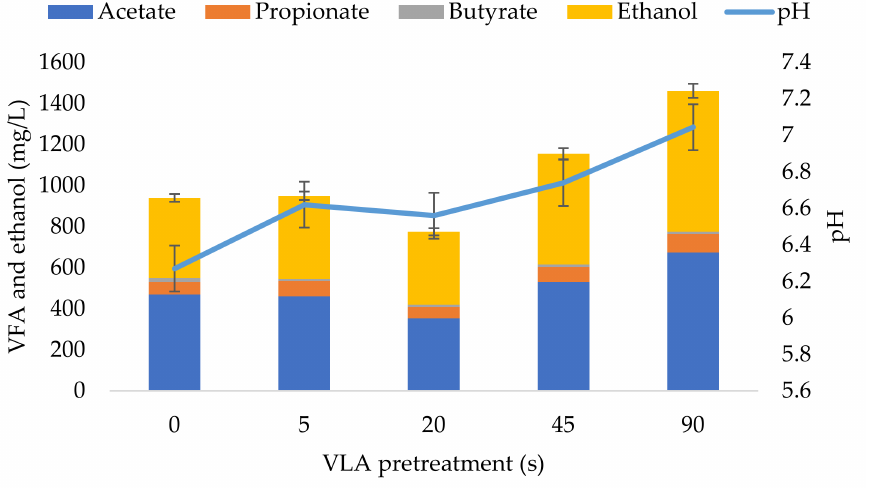
Figure 3. The content of VFA and ethanol in the CW depending on the pretreatment time. The sugar content showed a trend towards a decrease in the content of lactose in CW by 17.27, 11.59, 22.53, and 26.29% and glucose by 23.33, 15.86, 25.83, and 31.67% after 5, 20, 45, and 90 s pretreatment (Table 2). The largest decrease in the concentration of glucose and lactose was observed after 90 s of pretreatment, which correlates with the largest increase in the concentration of ethanol, propionate, and acetate. Perhaps this is due to the processes of electrooxidation, which can occur during the movement and collision of ferromagnetic particles in a rotating magnetic field